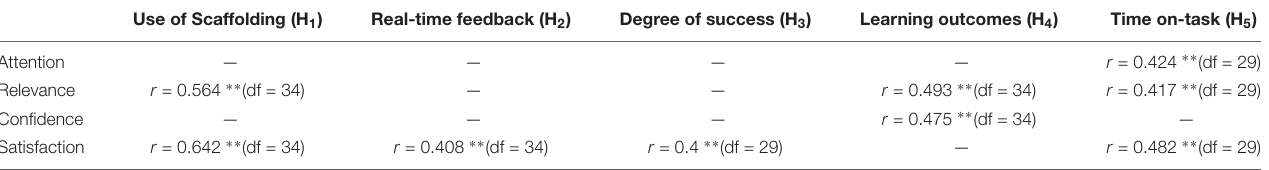
TABLE 5 | Correlation between the dimensions of the ARCS model and the variables in hypothesis H 1 , H 2 , H 3 , H 4 , and H 5 . Use of Scaffolding (H 1 )